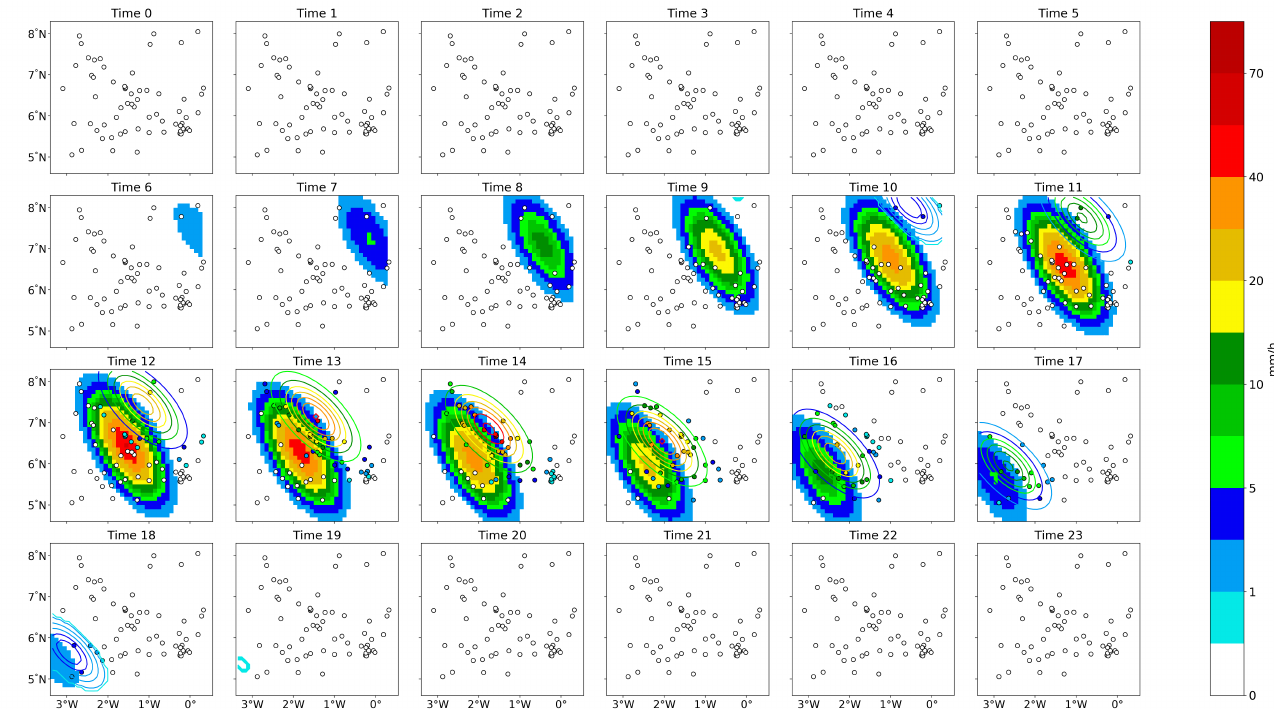
Figure 3. First guess u grid (background) and true precipitation field v grid (contour lines) for the synthetic case. The fictive station measurements v are represented by